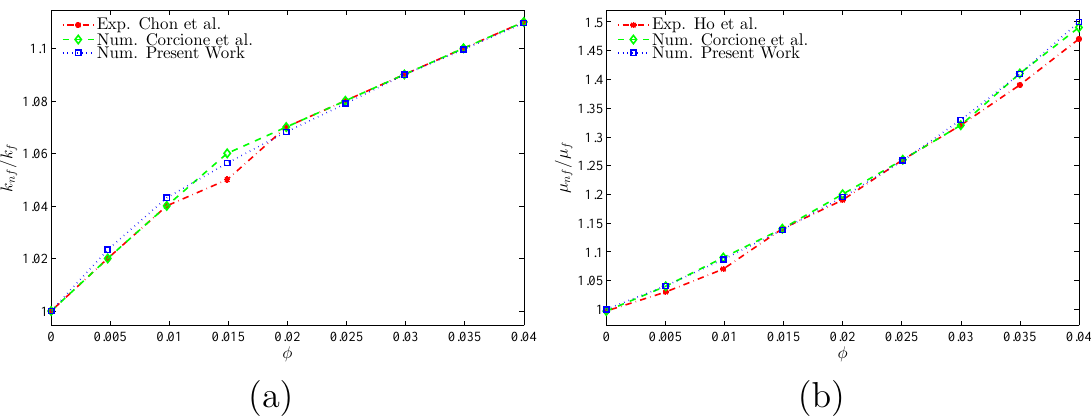
Figure 5. ( a ) Thermal conductivity ratio: present work vs. Chon et al. [40] and Corcione et al. [39]; ( b ) Dynamic viscosity ratio: present work vs. Ho et al. [36] and Corcione et al. [39].